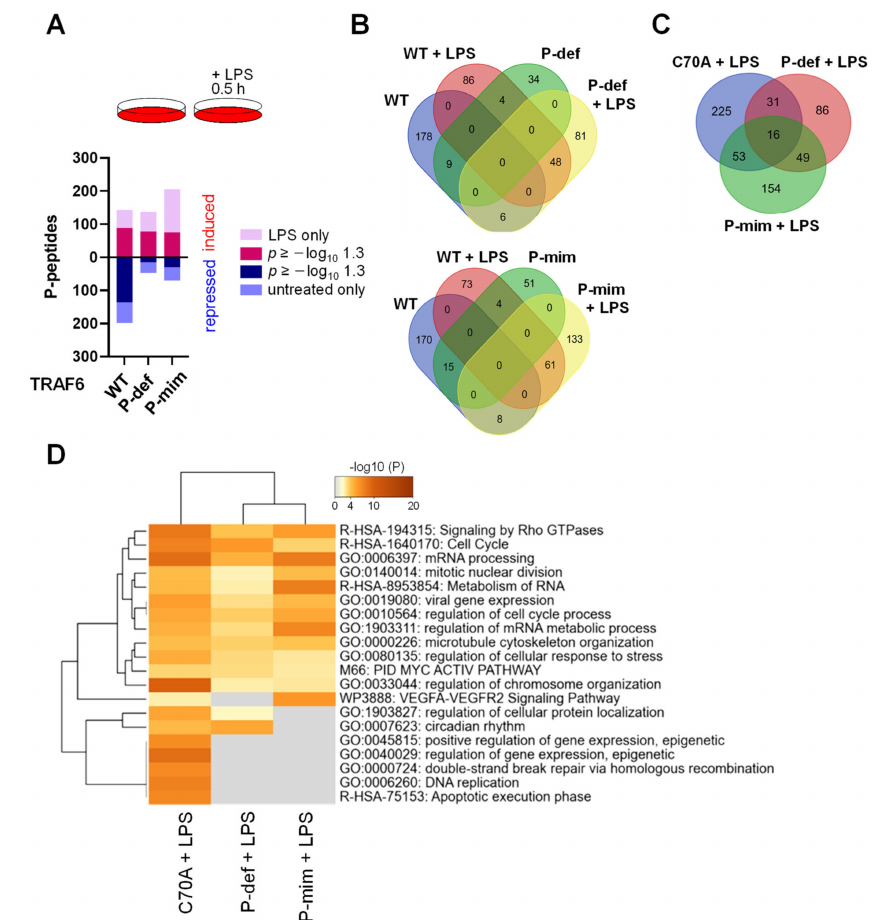
Figure 7. The impact of TRAF6 phosphorylation on LPS-triggered phosphorylation networks. ( A ) The top shows the experimental design; the lower part shows the number of phosphopeptides that were increased or decreased after LPS stimulation in the cells expressing TRAF6 and its phospho-mutants. ( B ) The Venn diagram shows a comparison of phosphopeptides (up or downregulation) determined the in unstimulated or LPS-treated cells as indicated. ( C ) Venn diagram comparing the dynamically regulated phosphopeptides in cells expressing TRAF6 C70A or the indicated TRAF6 phosphorylation site mutants. ( D ). Protein IDs mapping to the unique groups of deregulated phosphopeptides shown in the Venn diagram of ( C ) were further used to perform an overrepresentation (ORA) analysis using Metascape. The enriched pathway terms are indicated; the grey fields visualize lack of